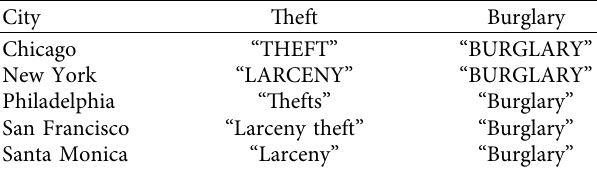
Table 1: Two types in each considered